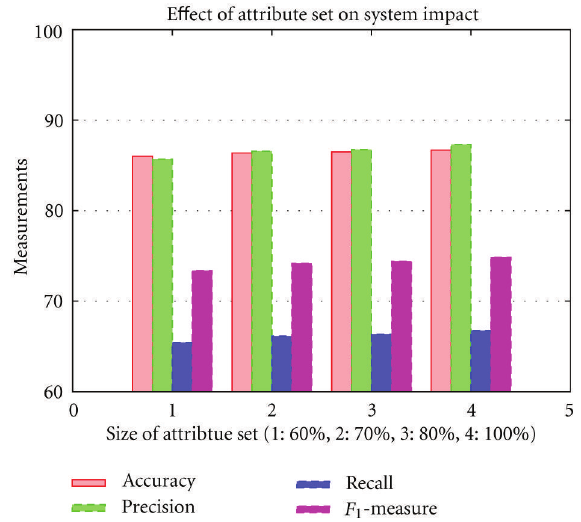
Figure 12: Relation between attribute set and categorization performance for Integrity Impact.